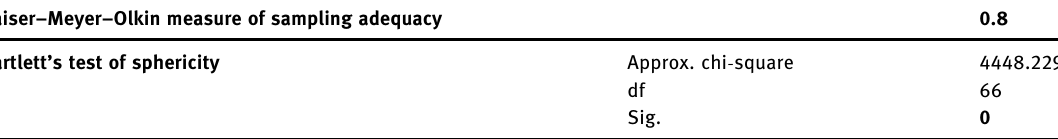
Table 2: KMO and Bartlett ’ s test on factor analysis of data from Taosi Kaiser – Meyer – Olkin measure of sampling